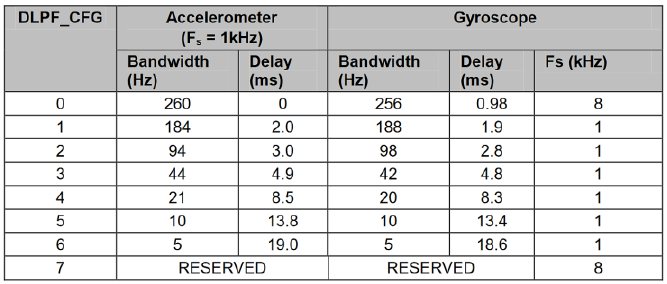
Figure 13. Inertial sensor’s digital low pass filter register map [37].